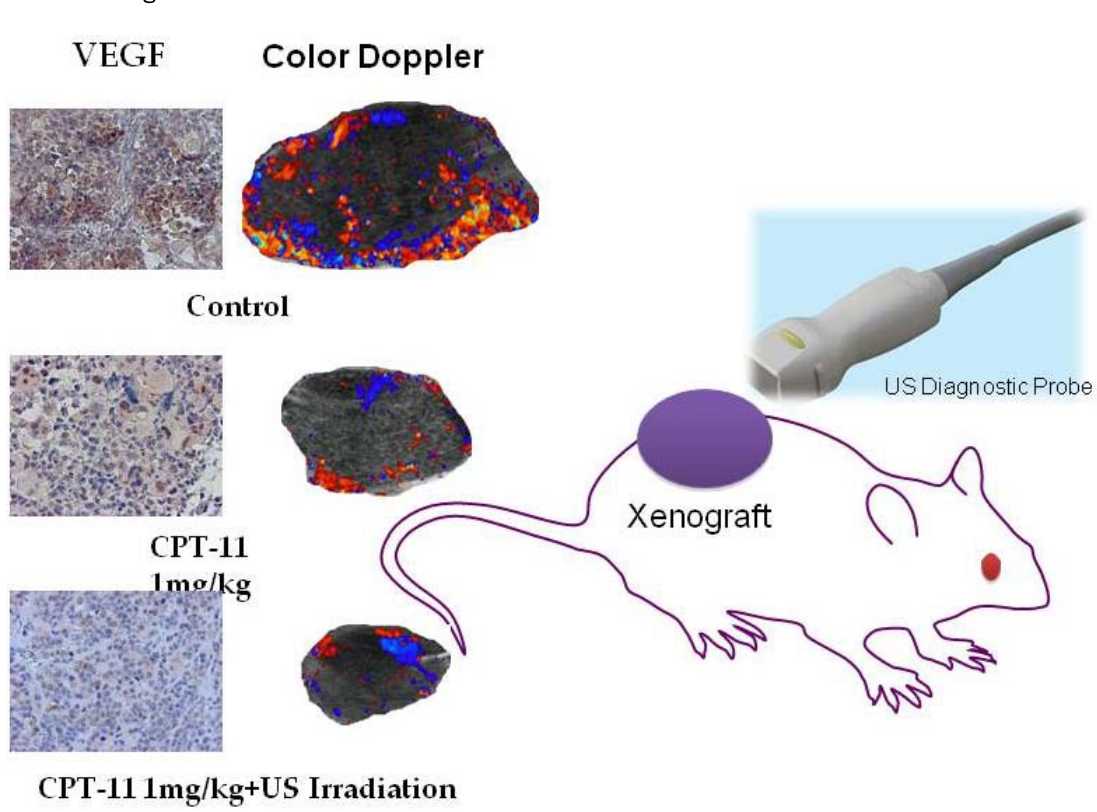
Figure 3. Evaluation of the intratumoral blood flow (angiogenesis) and expression of VEGF by color Doppler imaging: the concomitant therapy of CPT-11 and ultrasonic irradiation causes shrinkage of the tumor volume and significant decrease in intratumoral blood flow, as well as a slight reduction of